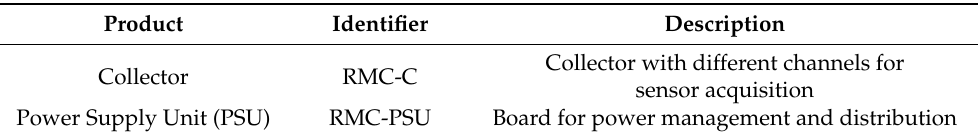
Table 3. ULD Components for